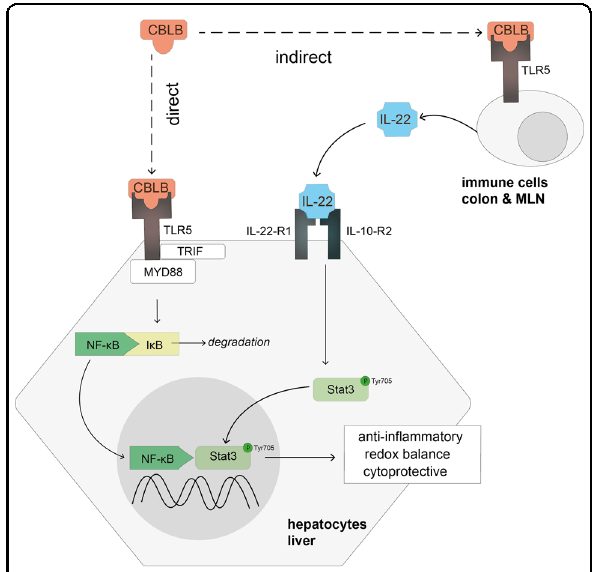
Fig. 5 Mechanism of CBLB, a TLR5 agonist, in hepatoprotection. Graphical summary of the direct and indirect action of CBLB on